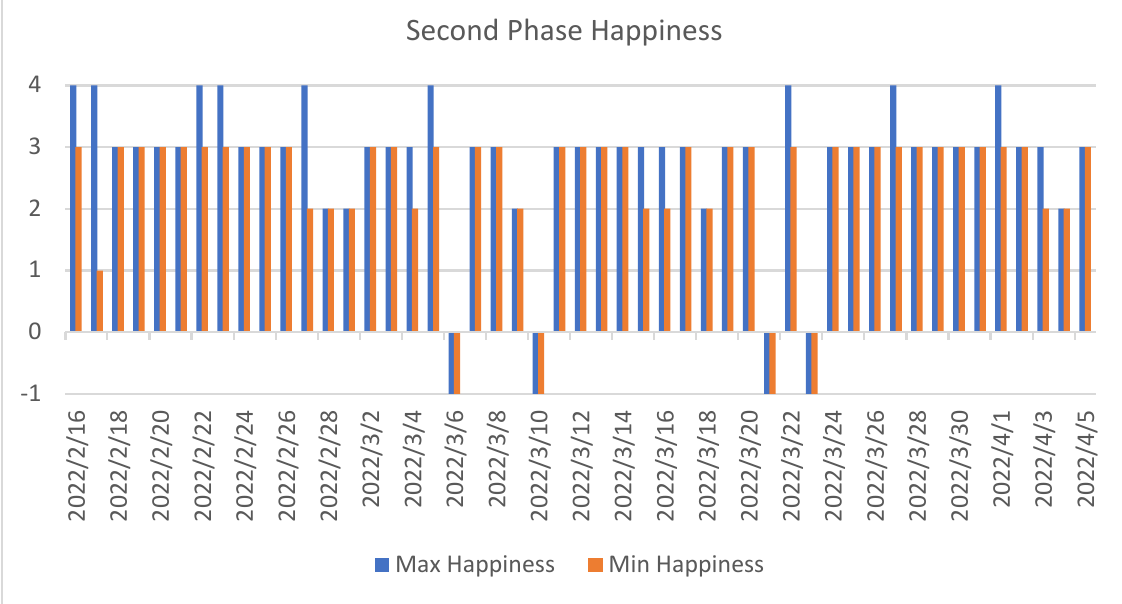
Figure 15. Second set of data from the first phase of the experiment. This figure shows the maximum and minimum happiness values recorded each day for the second subject.